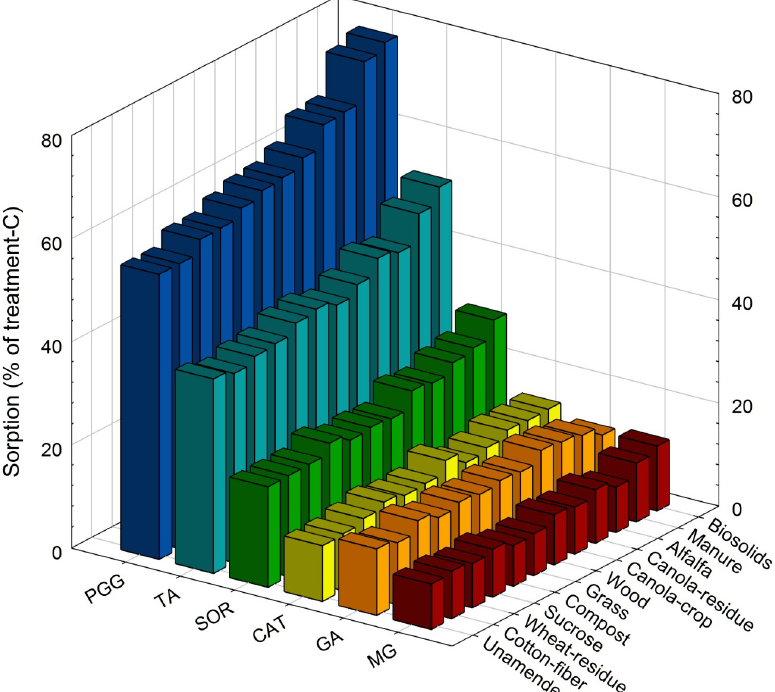
Figure 3. Effect of treatment by soil amendment interaction on average (n = 8) percent of Treatment-C remaining after a hot-water (16 hrs, 80 °C)